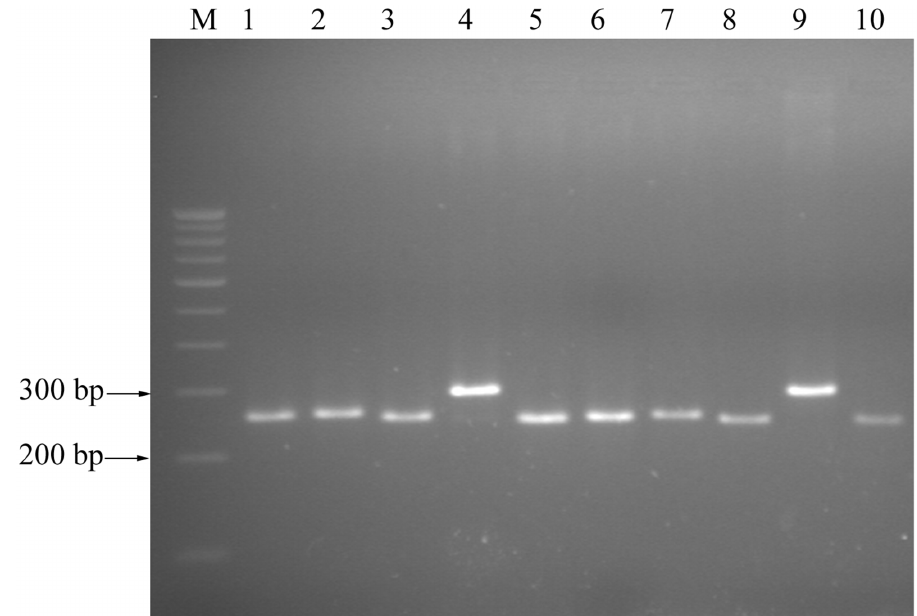
Fig 7. PCR amplification of black gram genic-SSR marker VMgSSR-78 in related Vigna